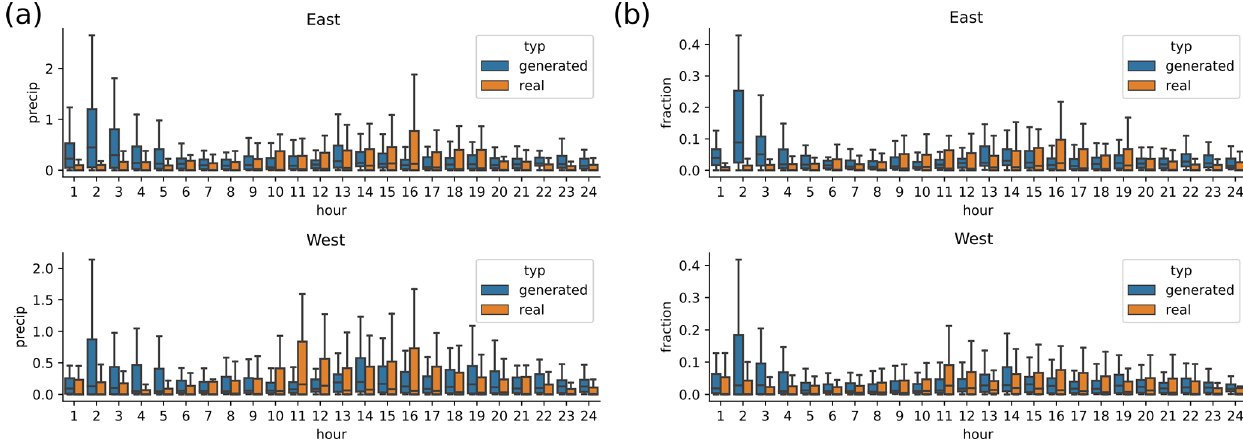
Figure E1. Results from the network with longitude as additional input. Daily cycle of 10000 randomly selected real observations and scenarios generated by conditioning on exactly the same 10000 daily sums, split up into western and eastern halves of the